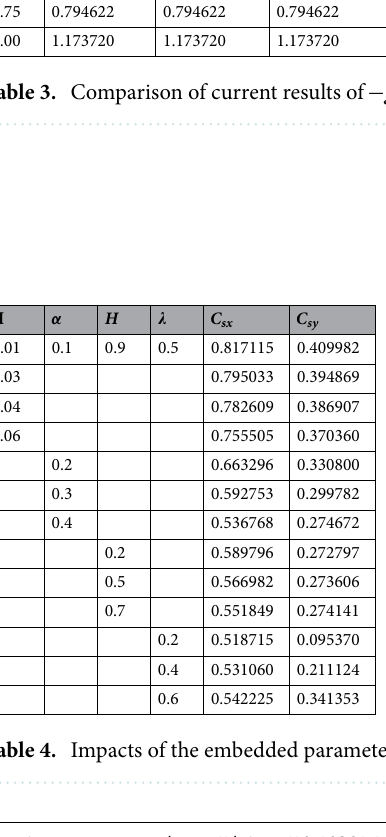
Table 3. Comparison of current results of